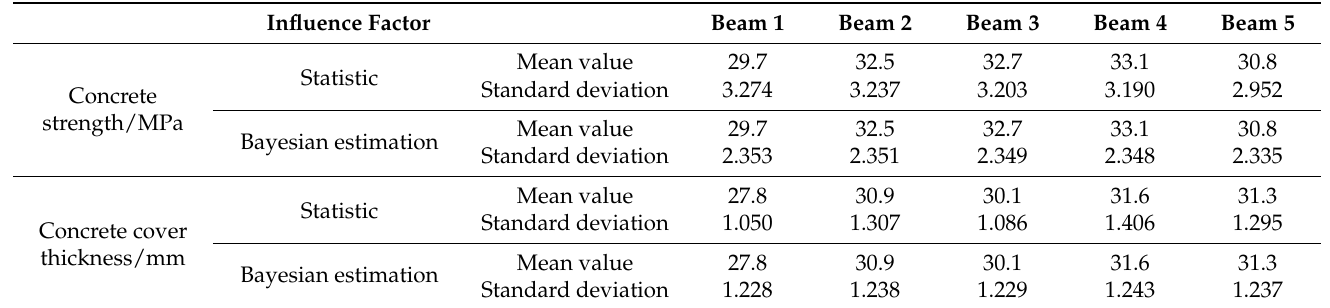
Table 3. Bayesian estimation results of concrete strength and cover thickness of the simply supported T-beam